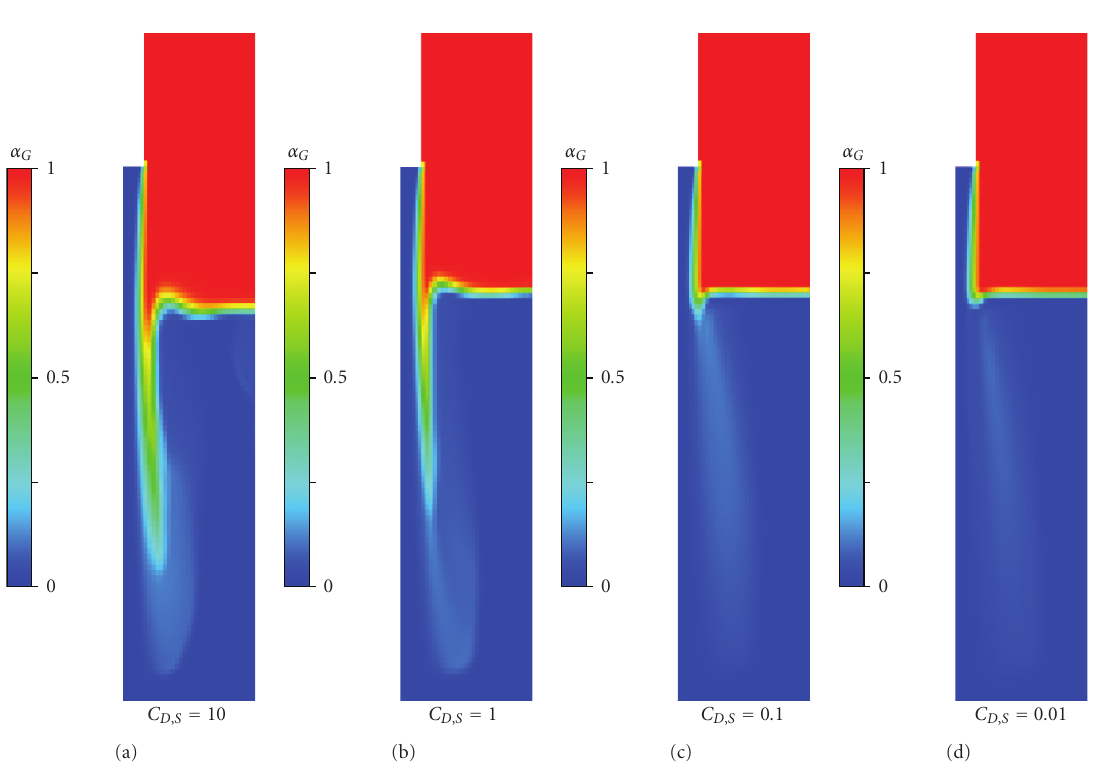
Figure 17: Gas void fraction for various surface drag coe ffi cients. Representative plots at time t > 10